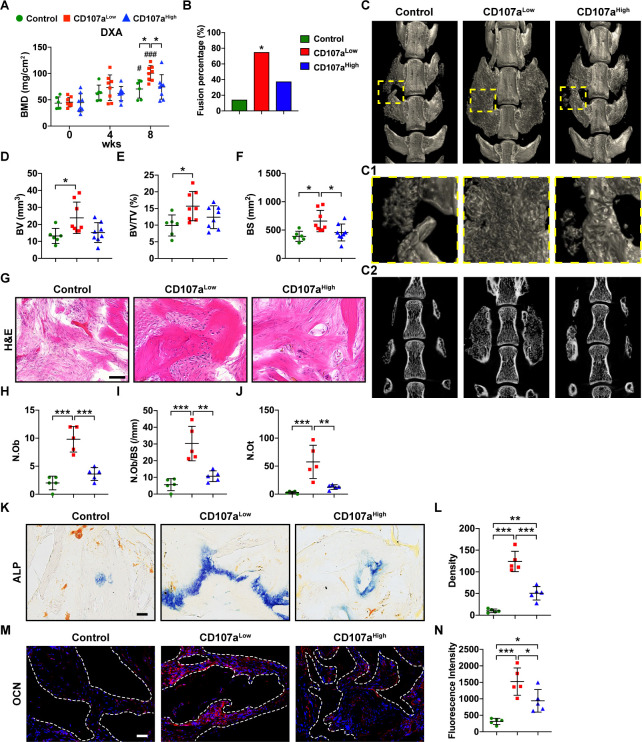
CD107alow mesenchymal cells induce spine fusion in vivo.FACS-purified CD107alowCD31-CD45- and CD107ahighCD31-CD45- mesenchymal cells from the same human subcutaneous WAT sample were implanted in equal numbers in a posterolateral spinal fusion model in athymic rats. A demineralized bone matrix (DBM) carrier was used, and an acellular control used as a further comparison. Animals were analyzed at up to eight wks post-operatively. (A) Bone mineral density (BMD) assessed by DXA (dual-energy X-ray absorptiometry) within the lumbar implantation site, at 0, 4, and 8 wks. (B) Spine fusion rate, assessed by manual palpation after eight wks. *: CD107alow compared with acellular control. (C) Representative micro-computed tomography (μCT) reconstruction images of the spine fusion site among CD107alow and CD107ahigh treated samples, in comparison to acellular control. Images are shown from the dorsal aspect. (C1) Corresponding high magnification μCT reconstruction of the fusion site. (C2) Corresponding coronal μCT cross-sectional image. (D–F) μCT-based quantification of bone formation within the spine fusion site, including (D) Bone volume (BV), (E) fractional Bone volume (BV/TV), and (F) bone surface (BS). (G) Representative histologic appearance by routine H and E of the implant sites among control (DBM only), CD107alow, and CD107ahigh cell grafts within the spine fusion site. (H–J) Bone histomorphometric measurements among each treatment group, including (H) osteoblast number (N.Ob), (I) osteoblast number per bone surface (N.Ob/BS), and (J) osteocyte number (N.Ot). (K,L) Representative alkaline phosphatase (ALP) staining appearing blue (K), and photographic quantification within the spine fusion site (L). (M) Representative Osteocalcin (OCN) immunohistochemical staining (M), and photographic quantification within the spine fusion site (N). OCN immunostaining appears red, while DAPI nuclear counterstain appears blue. Dots in scatterplots represent values from individual animal measurements, while mean and one SD are indicated by crosshairs and whiskers. #p<0.05 and ###p<0.001 in relation to corresponding 0 wk timepoint; *p<0.05; **p<0.01; ***p<0.001. Statistical analysis was performed using a two-way ANOVA (A) or one-way ANOVA followed by Tukey’s post hoc test (D–N). N = 6–8 animals per group. Black and white scale bars: 50 μm.